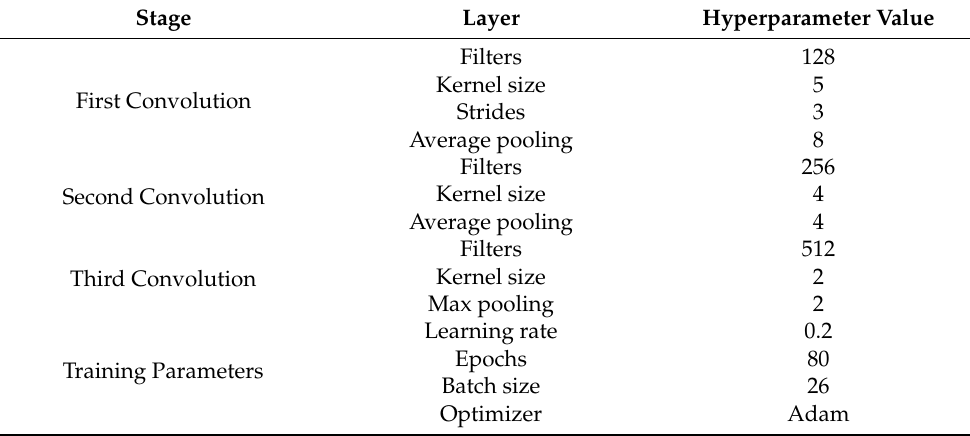
Table 4. Hyperparameters utilized for